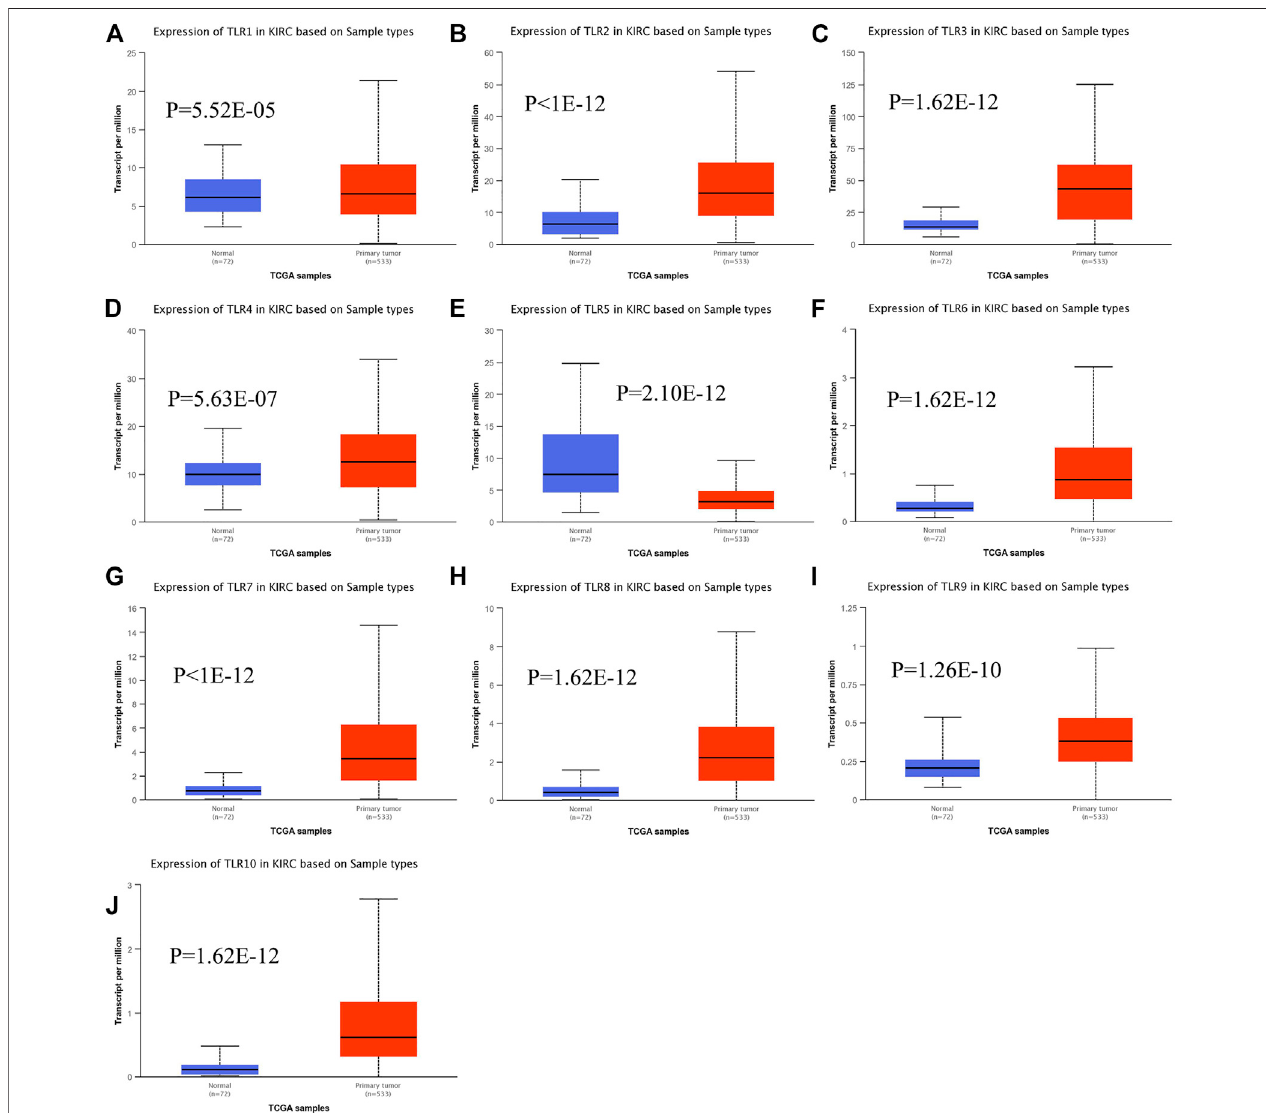
FIGURE 2 | The transcript expression levels of TLRs in KIRC. Box plots showing the transcript expression levels of TLR1 (A) , TLR2 (B) , TLR3 (C) , TLR4 (D) , TLR5 (E) , TLR6 (F) , TLR7 (G) , TLR8 (H) , TLR9 (I) and TLR10 (J) in KIRC compared with normal tissues.